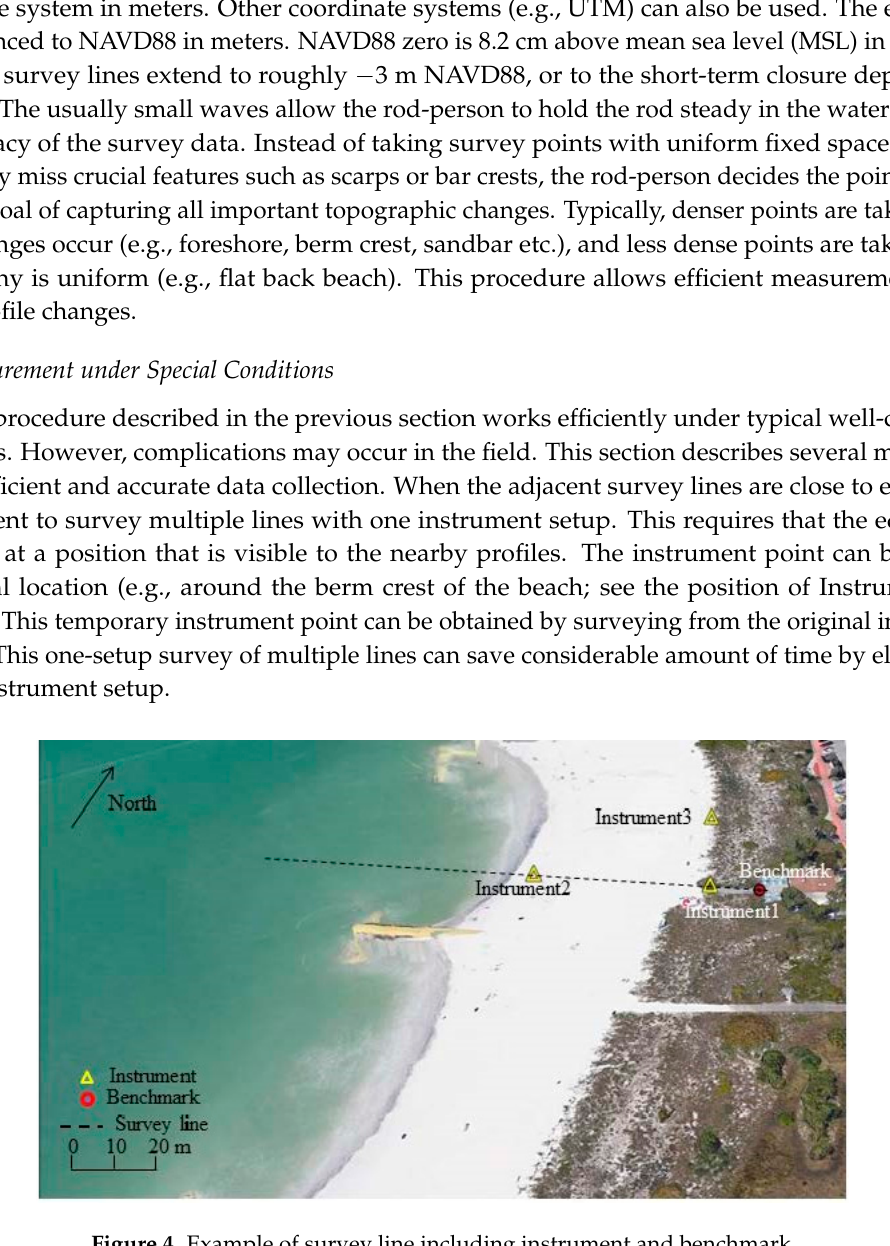
Figure 4. Example of survey line including instrument and benchmark.